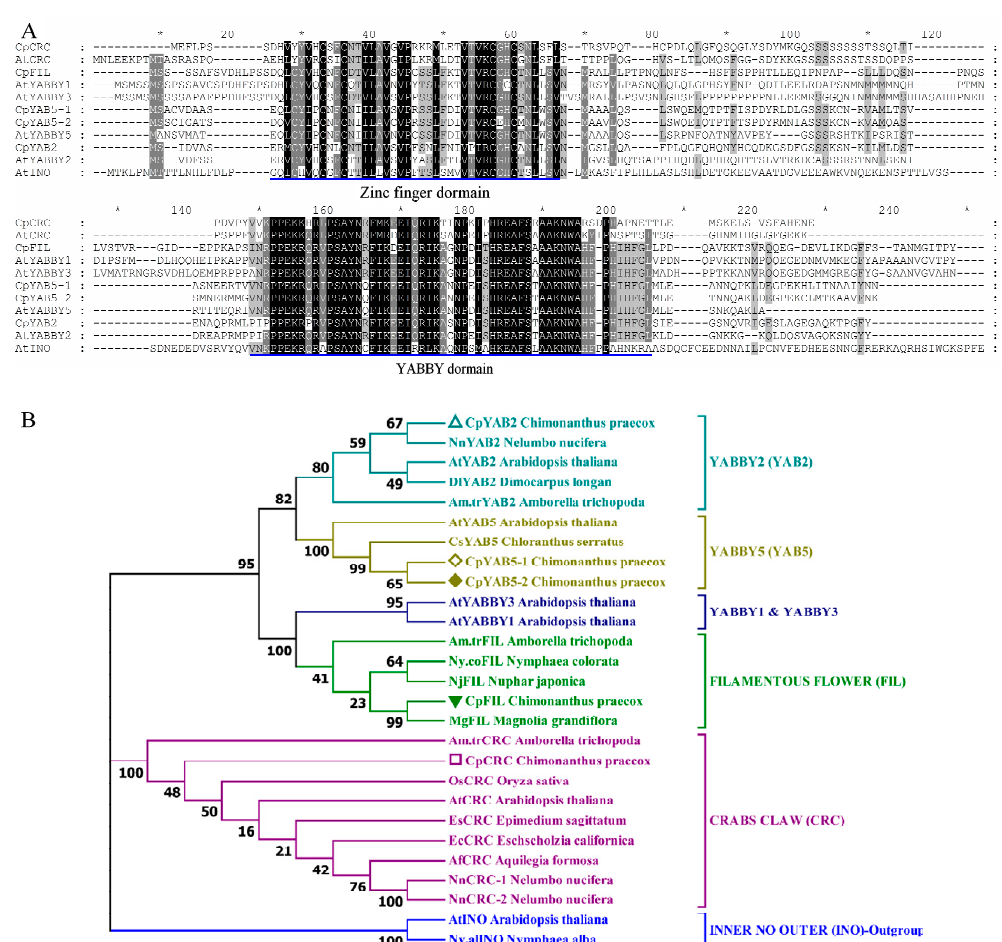
Figure 4. Sequence alignment and phylogenetic analysis of YABBY proteins. ( A ) Sequence alignment of YABBY proteins in C . praecox and A . thaliana . Conserved domains (Zinc finger domain and YABBY domain) are underlined in blue. Identical residues are highlighted in black and similar residues are highlighted in grey. Dotted line and asterisk represented the gap and the position of odd times of ten in protein sequence. ( B ) Phylogenetic analysis by Neighbor-joining (NJ) bootstrap analysis (1000 replications). AtINO ( A . thaliana ) and Ny.alINO ( Nymphaea alba ) as outgroup. The gene accession number is shown in Materials and Methods. Five different symbols in front of the protein name reprent the five YABBY protein of Chimonanthus praecox in this study.